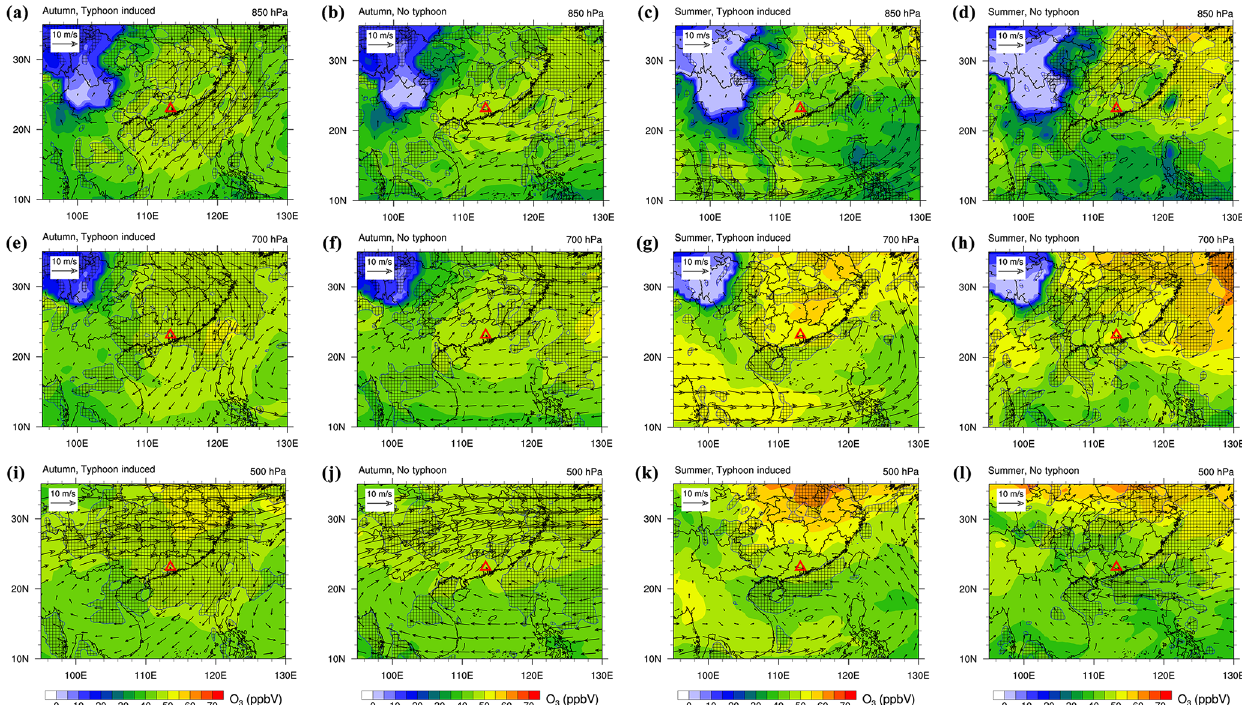
Figure 5. O 3 mixing ratio (ppbv – parts per billion by volume) and wind fields at the height of (a–d) 850hPa, (e–h) 700hPa and (i–l) 500hPa at 14:00LT for each scenario, i.e. (a, e, i) autumn (typhoon-induced), (b, f, j) autumn (no-typhoon), (c, g, k) summer (typhoon-induced) and (d, h, l) summer (no-typhoon). The red triangle in each plot indicates the PRD. The gridded areas indicate that vertical wind speed is less than zero or where downdraughts